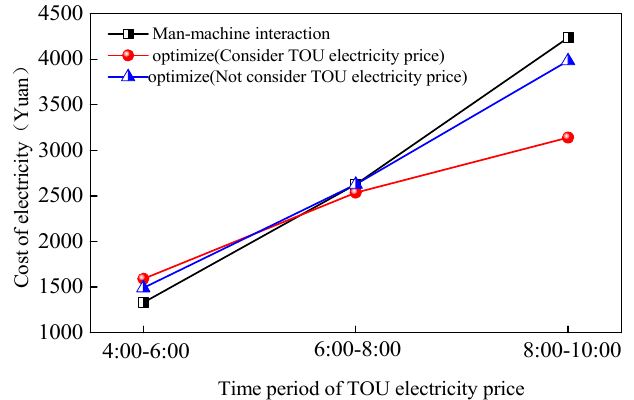
Figure 14. Electricity costs at different TOU electricity pricing periods